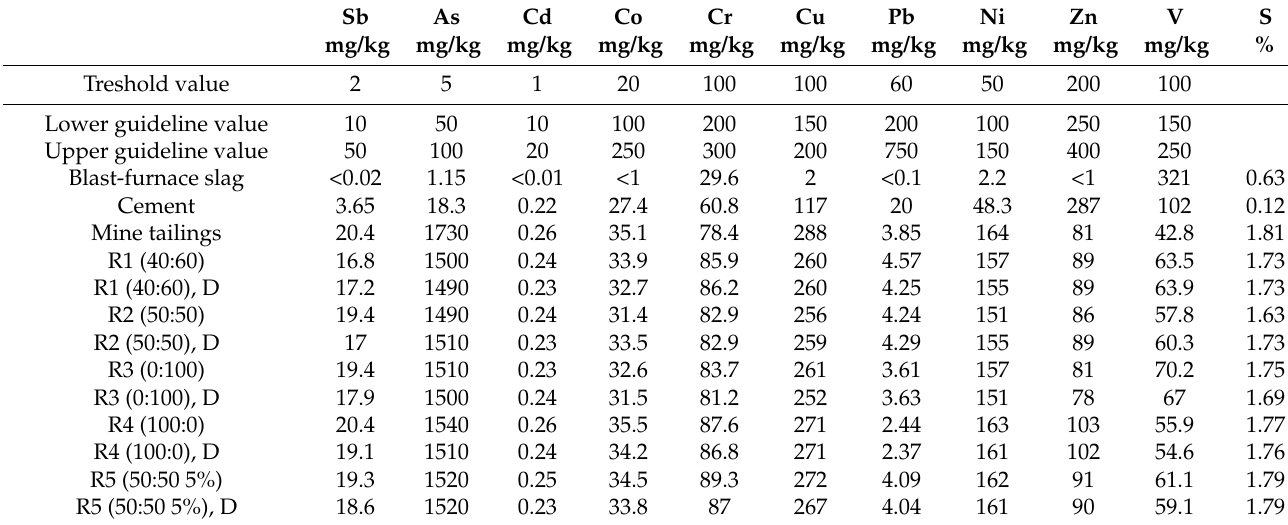
Table 4. Comparison of five CPB recipes with aqua regia leaching results to guideline values of Finnish management strategy of contaminated land [30]. Explanation for R1–R5, see Table 1. D denotes duplicate sample.